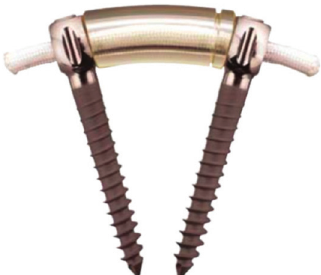
Figure 1: The Dynesys system consists of titanium alloy screws, PET cords, and PCU